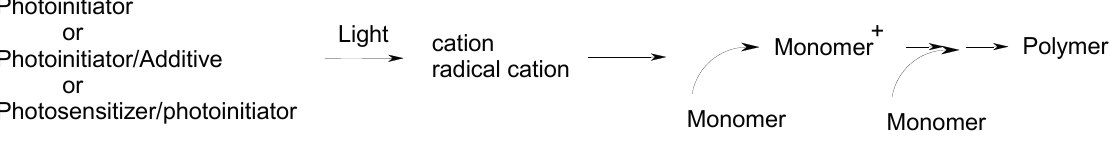
Scheme 1. General scheme for cationic